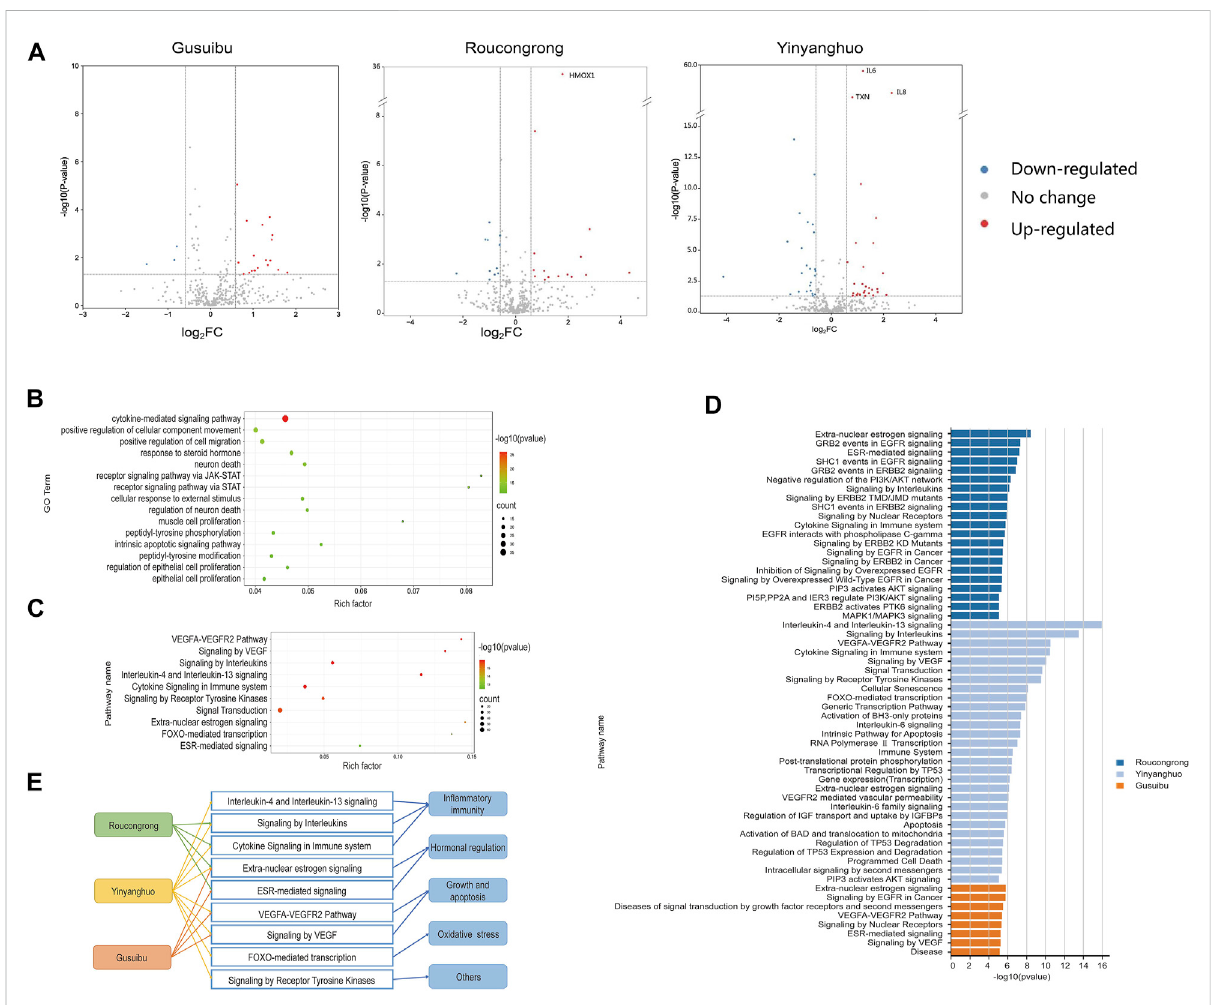
FIGURE 4 Functional analysis of WSYR DEGs based on transcriptome analysis (A) Volcano map of DEGs of Roucongrong, Yinyanghuo and Gusuibu. Red dots: upregulated genes; green dots: downregulated genes; black dots: unchanged genes (B) Bubble chart of GO biological processes enriched among the 92 DEGs related to WSYR (top 15) (C) Bubble chart of pathways enriched among the 92 DEGs related to WSYR (top 10) (D) Pathway enrichment analysis of DEGs in Roucongrong, Yinyanghuo and Gusuibu ( p value ≤ 10 − 5 ) (E) Comparison of pathways regulated